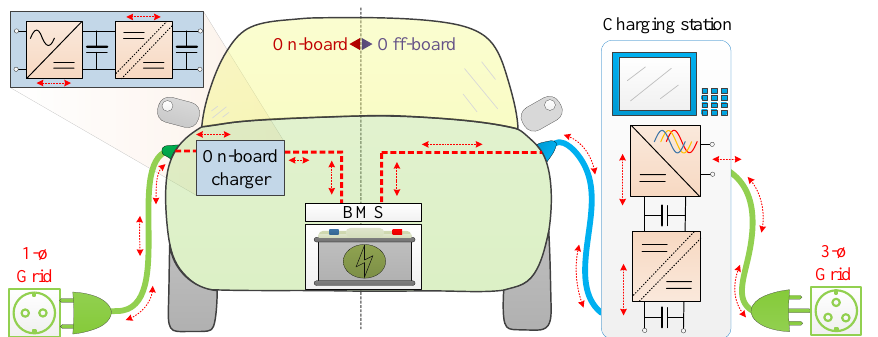
Figure 1. A simplified structure of single phase (on-board) and three-phase (off-board) bidirectional EV charging.